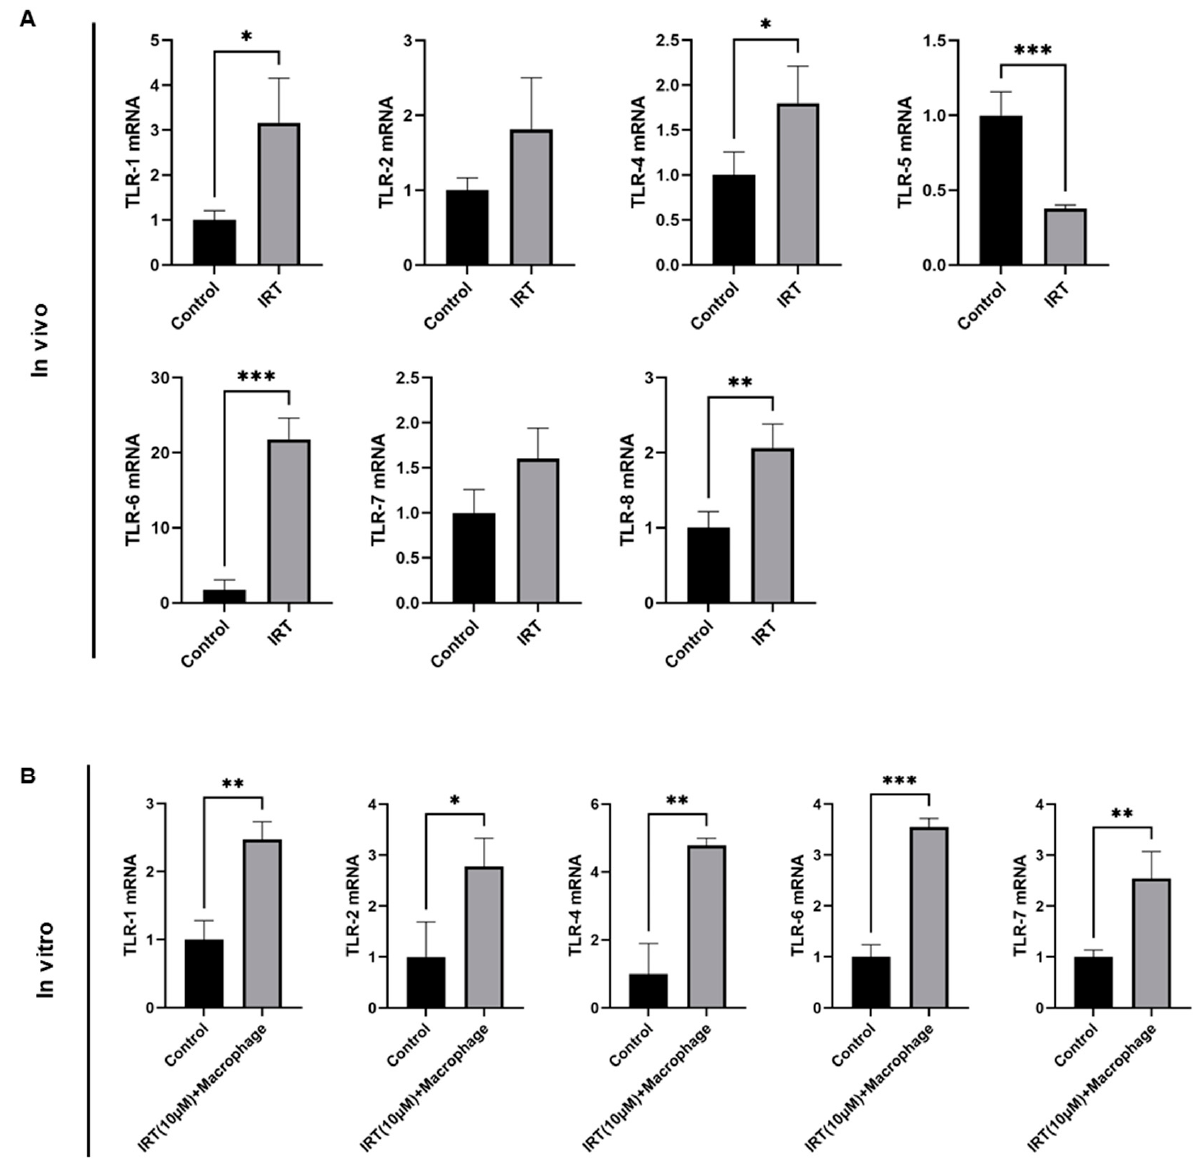
Figure 4. Irinotecan promotes upregulation of TLR family expression. In in vitro experiments, total RNA was extracted for subsequent qPCR experiments after treating macrophages with 10 µ M of irinotecan for 24 h. ( A ) Changes in TLR family mRNA expression levels in mice livers after irinotecan treatment. ( B ) Primary peritoneal macrophages were treated with 10 µ M irinotecan for 24 h, and TLR family mRNA expressions were measured by qPCR. Data are reported as mean ± SD, and each graph is representative of at least three independent experiments. Comparison of values was performed by one-way ANOVA for unpaired data. * p < 0.05; ** p < 0.01; *** p < 0.001.